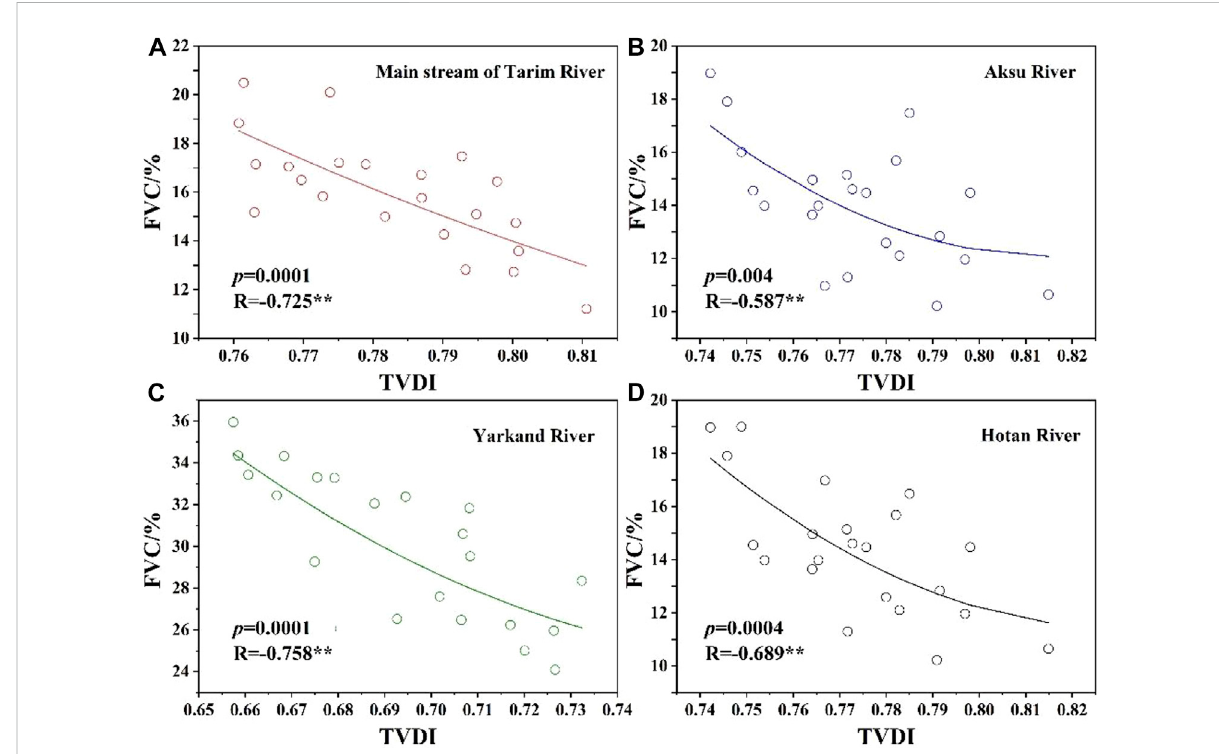
FIGURE 8 Correlation analysis of FVC andTVDI. (A) is main stream of Tarim River, (B) is Aksu River, (C) is Yarkand River, (D) is Hotan River.